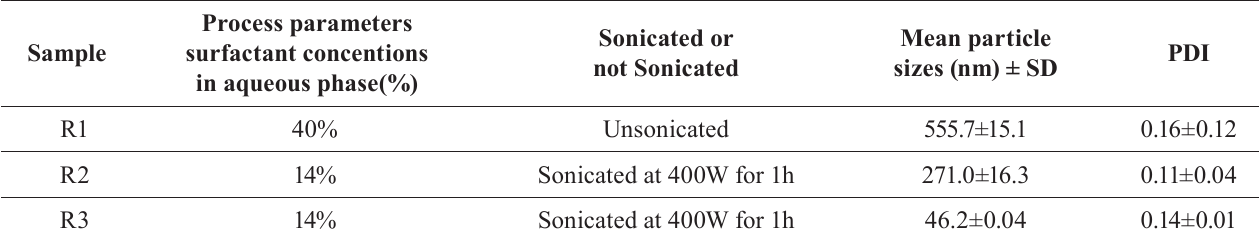
TABLE I - P rocess parameters for the preparation of different particle-sized ISL nanocrystals